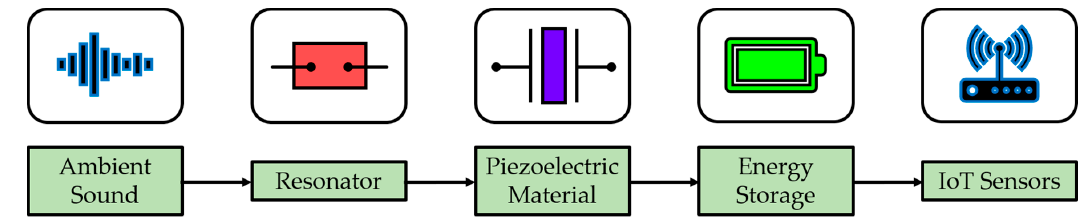
Figure 7. A schematic design of a general acoustic energy harvesting (AEH) system.